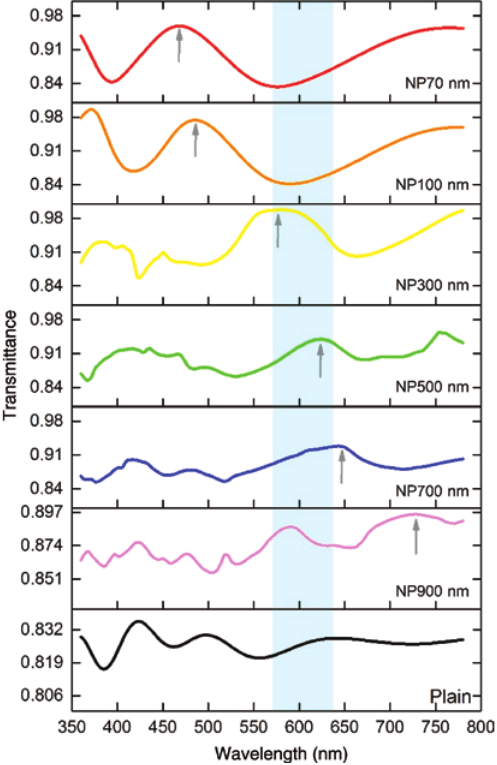
Figure 5: Calculated light transmittance spectra of different MQW samples; cyan region represents the range of emission wavelength (570–637